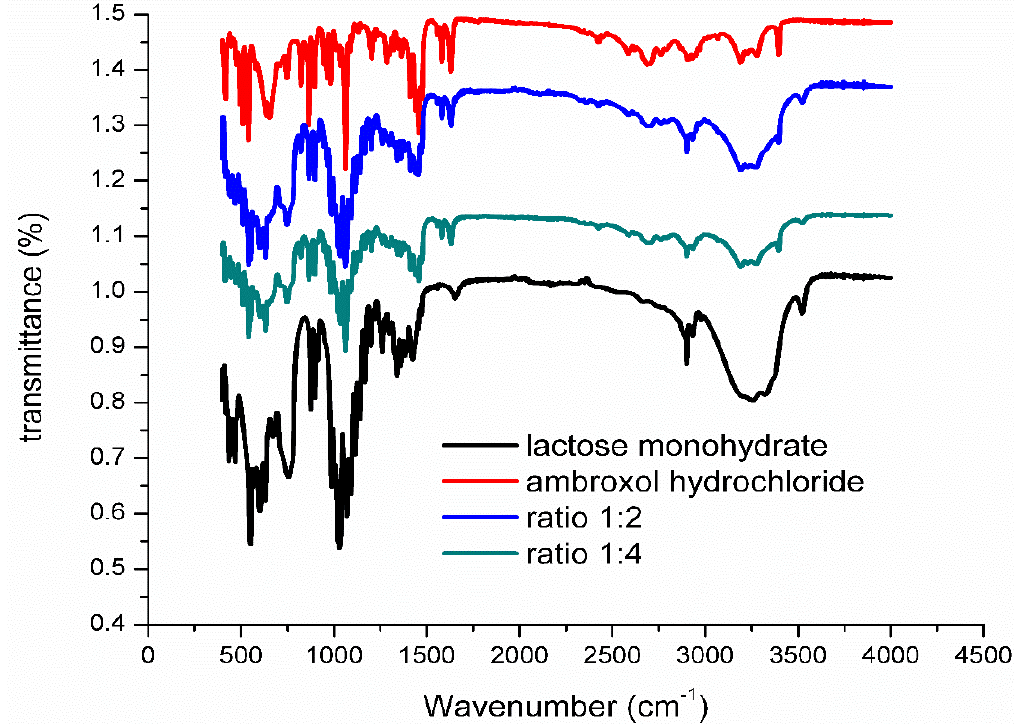
Figure A2. FTIR spectra of pure AMB, Mg stearate, and AMB/Mg stearate mixture in 1:2 and 1:4 ratio.